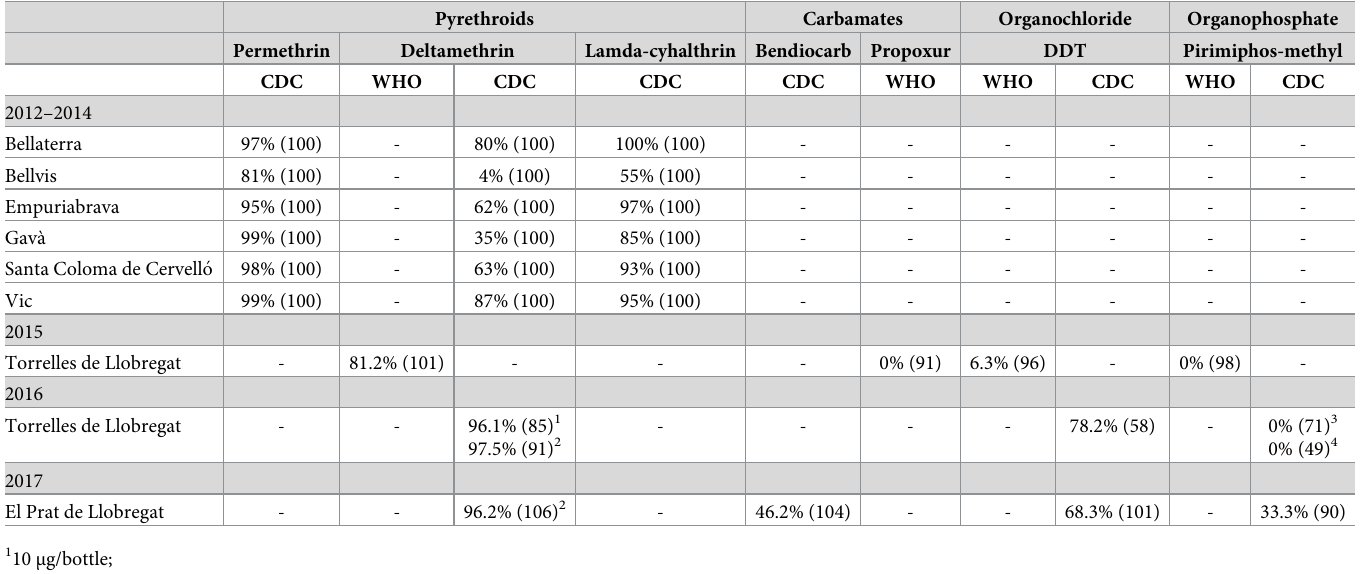
Table 2. Insecticide susceptibility of Cx . pipiens collected from various localities in Catalunya (Spain). Percentage indicates percent mortality (WHO tube tests: 24 h following 1 h exposure; CDC bottle assays: At discriminating exposure time of 30 min (45 min for DDT)); number between parentheses indicates the number of mosquitoes